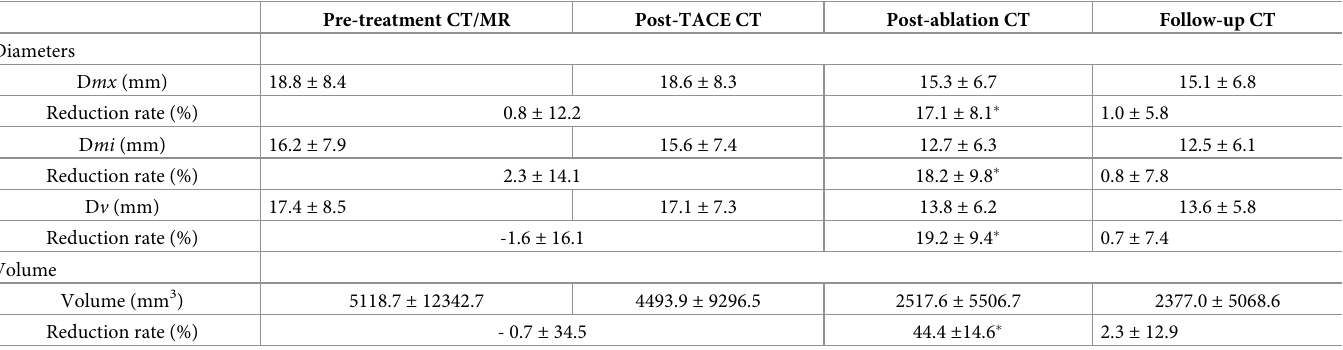
Table 2. Three-dimensional diameters and volumes of hepatocellular carcinomas and reduction rates achieved by radiofrequency ablation after transcatheter arte- rial chemoembolization.